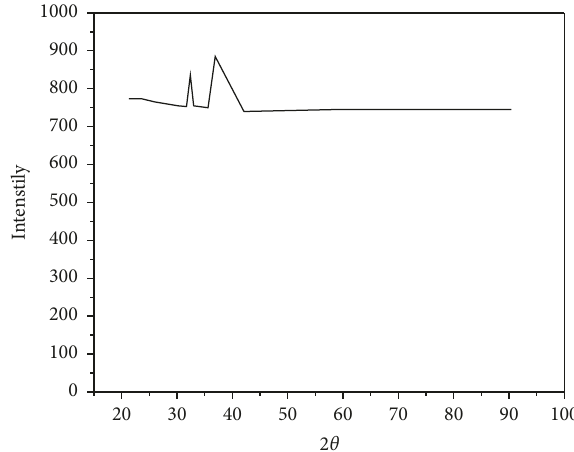
Figure 3: XRD spectra of the films obtained after heat treatment of particle-free ZnO inks at different temperatures for